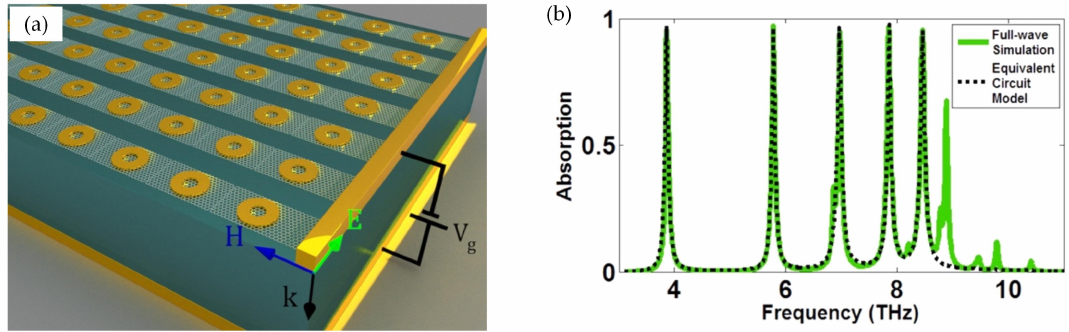
Figure 6. ( a ) schematic of penta-band graphene metasurface absorber; ( b ) the absorption spectra achieved with full-wave simulation (green solid line) and equivalent circuit model (black dashed line), reprinted with permission from Ref.